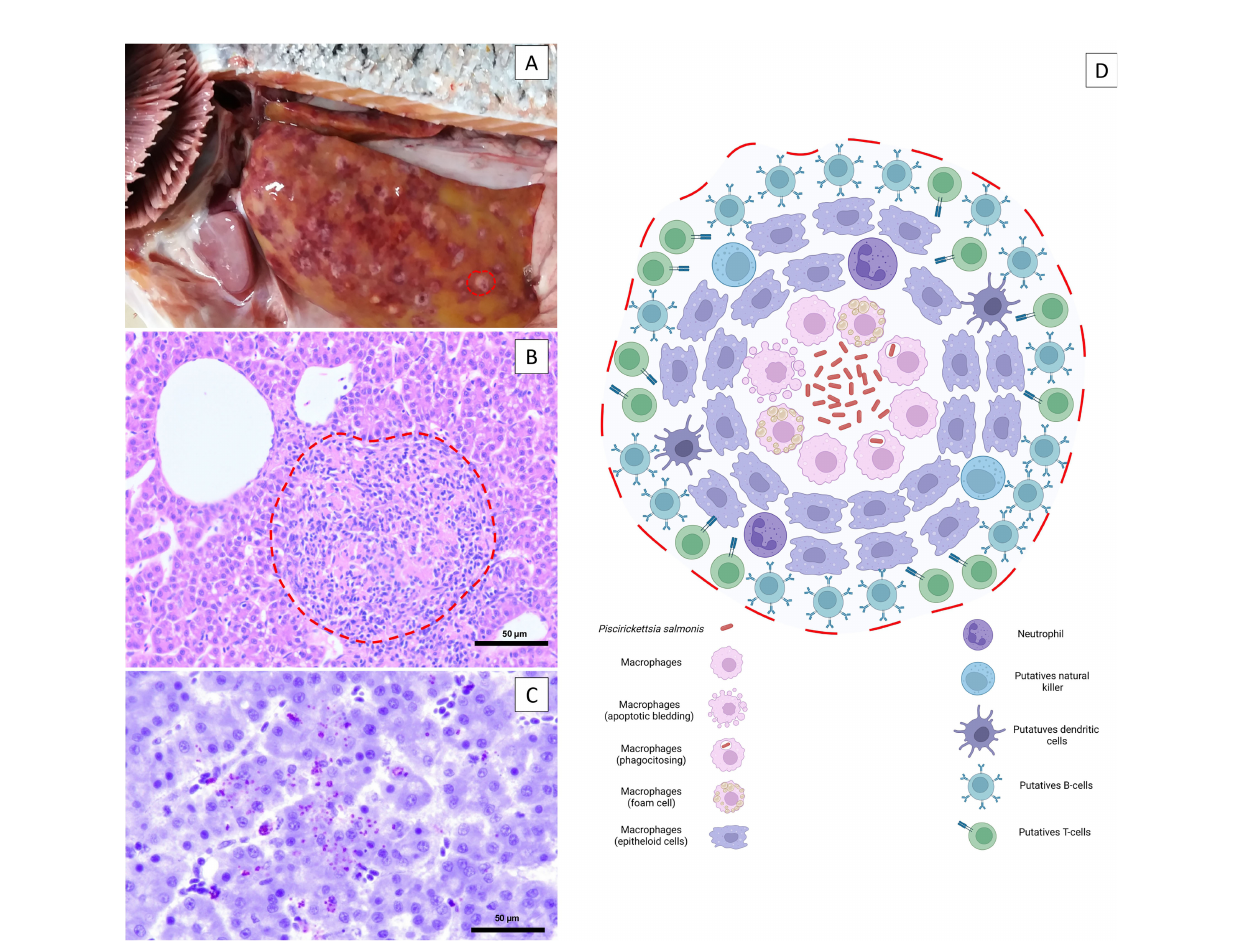
FIGURE 1 | Macroscopic pathology and microscopic lesions in the liver associated with SRS infection. (A) Pale liver with subcapsular and circular reddish and gray – yellow mottled areas approximately 1-6 mm in diameter. The dashed red line delineates the borders of a gray – white discrete nodule characteristic of P. salmonis infection. (B) Multifocal necrosis of hepatocytes, diffuse in fi ltration of in fl ammatory cells and focal granuloma and/or multifocal coalescent granulomas. The dashed red line delineates the borders of a focal granuloma. Bar. 50 µm. (C) Immunolocalization of extracellular P. salmonis in the central zone of necrotic lesions and intracellular P. salmonis within macrophages using immunohistochemistry. Bar. 50 µm. (D) The yellowish-white nodules are granulomas typically consisting of a central necrosis with the presence of the bacteria, surrounded by macrophages at different stages, neutrophils, putative dendritic cells, and natural killer cells; all of these are surrounded by lymphocytes (putative T- and